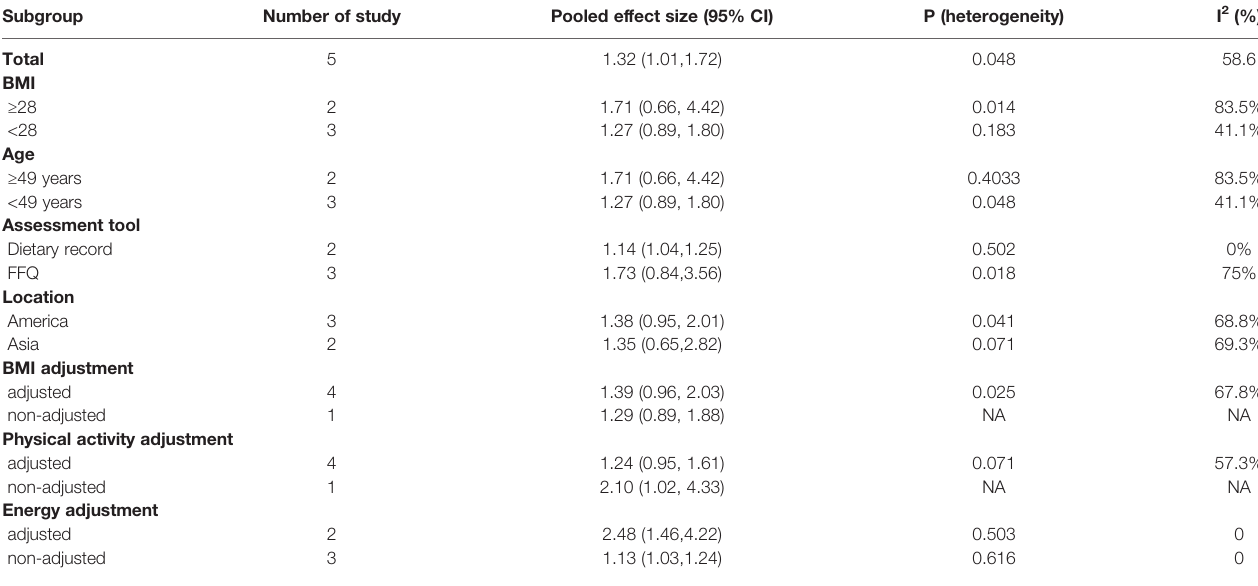
TABLE 3 | Subgroup analyses of the association between the DII score and diabetes mellitus. Risk estimates refer to the highest vs. lowest DII categories. Subgroup